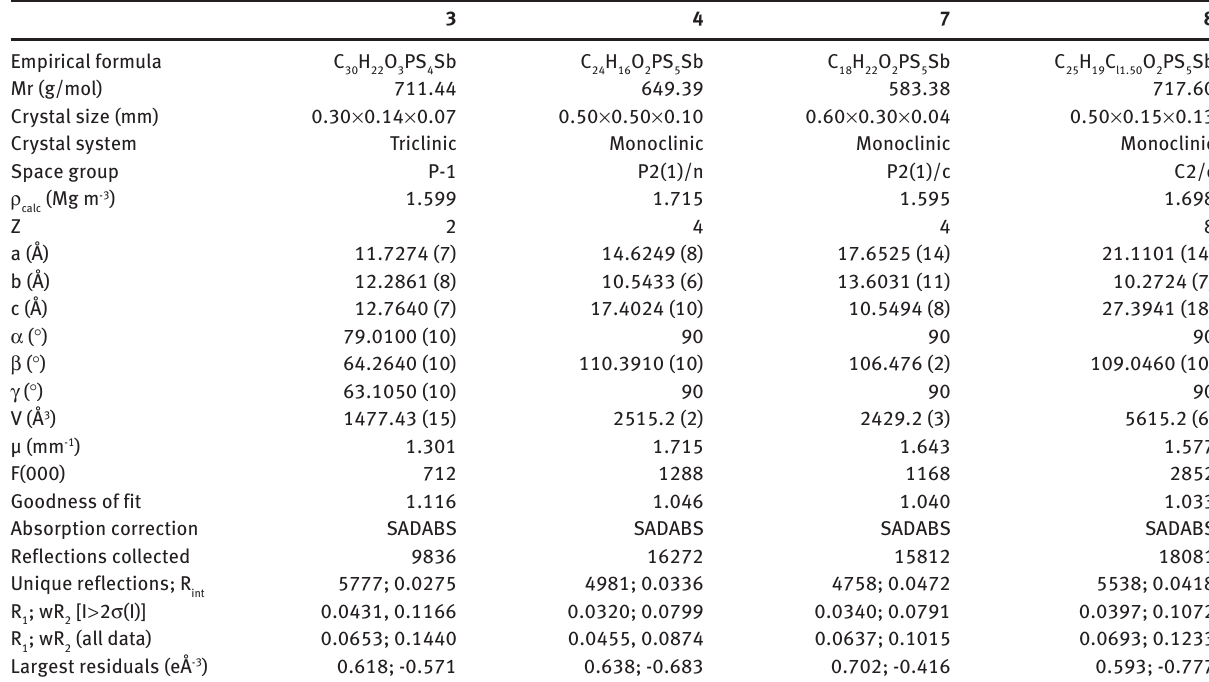
Table 2 Selected crystallographic data for compounds 3 , 4 , 7 , and 8